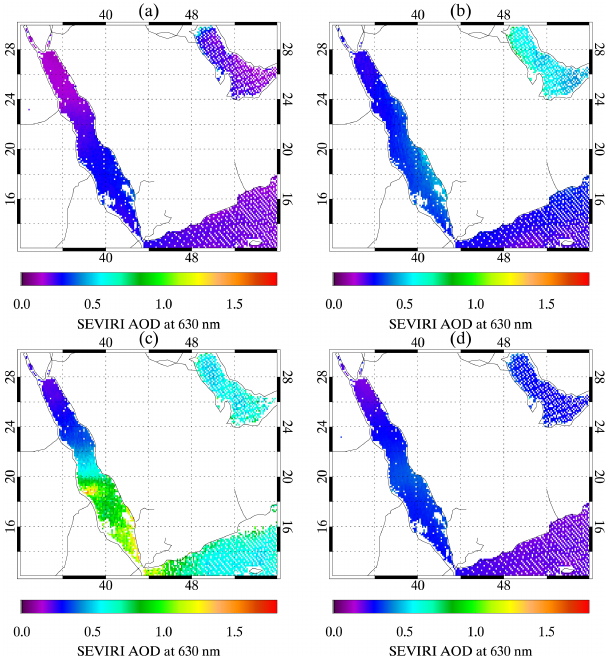
Figure 3. Maps of “climatological” (2005–2015) monthly average AOD from SEVIRI at 630nm. Panel (a) indicates measurements for January, (b) April, (c) July, and (d) October.